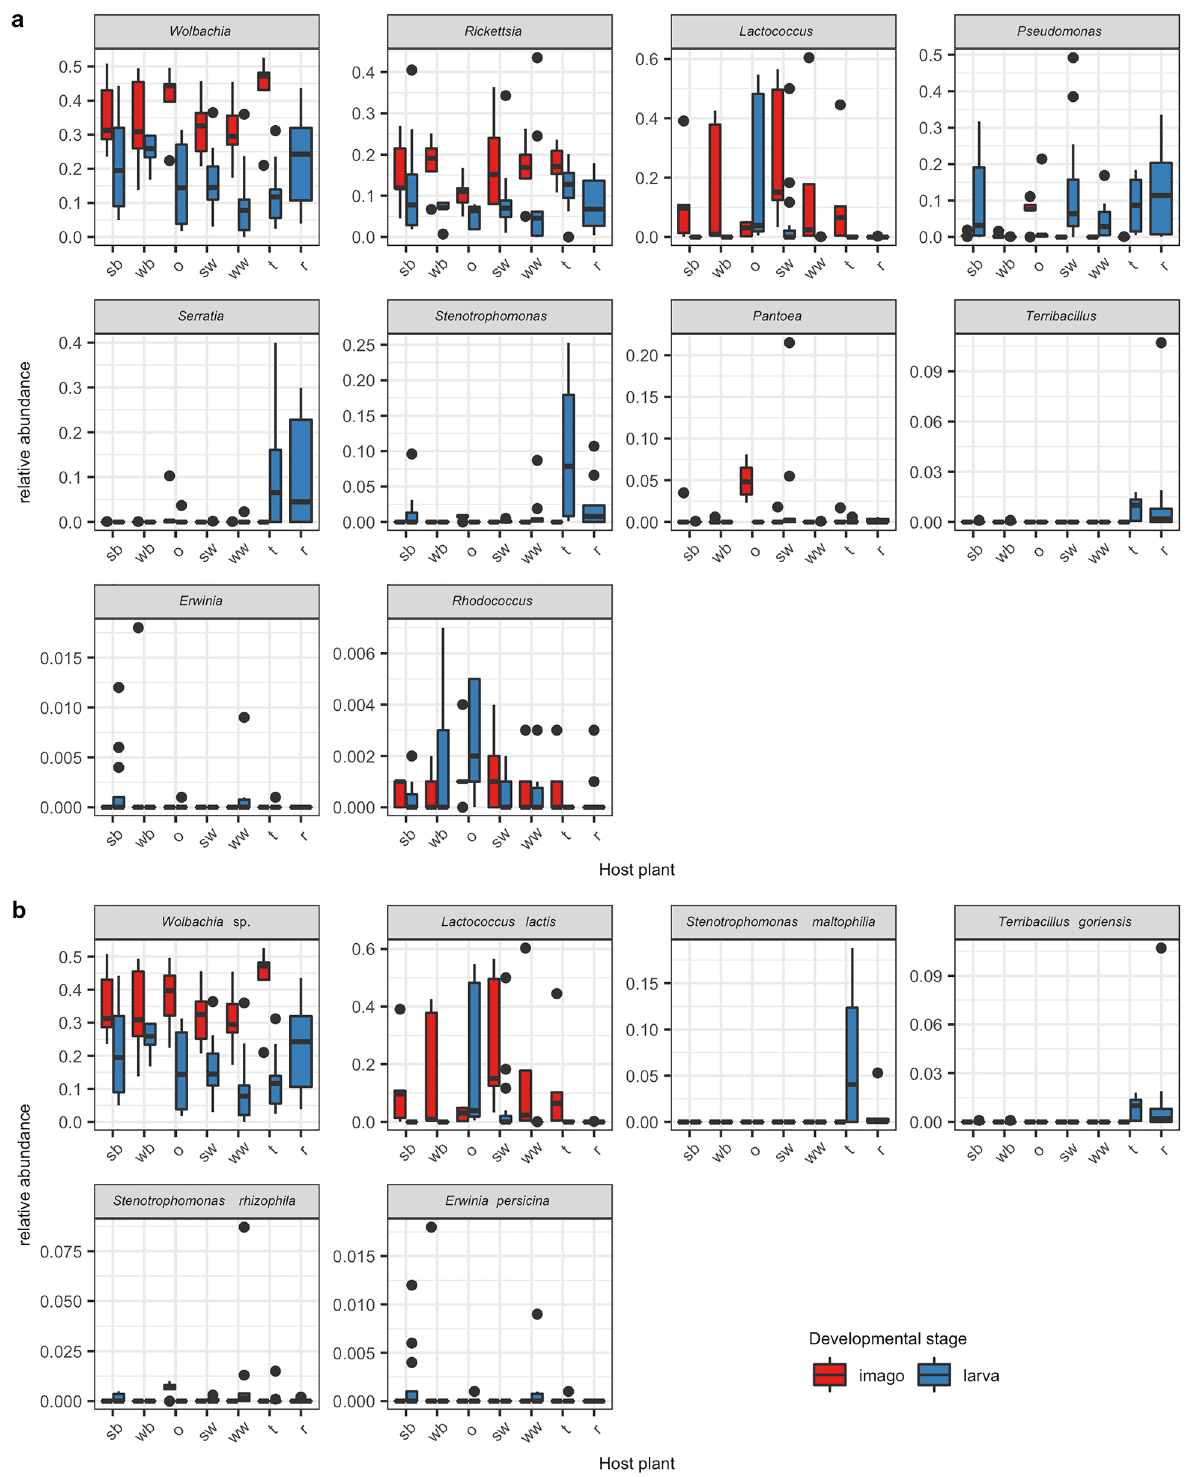
Figure 7. Boxplots visualizing the relative abundance of ( a ) 10 Top Biome genera of bacteria; ( b ) 6 Top Biome identified species of bacteria depending on the variable CLB developmental stage (larva, imago) and cereal plant hosts from which insects were collected. sb: spring barley; wb: winter barley; o: oat; sw: spring wheat; ww: winter wheat; t: triticale; r: